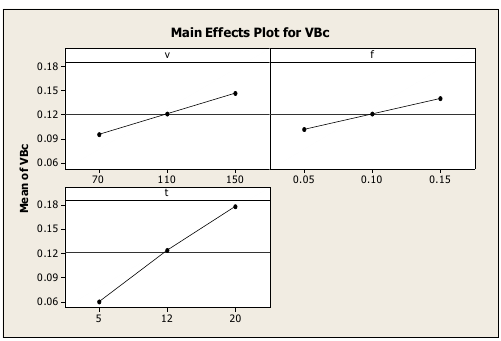
Fig. 3. Main effect plot of flank wear